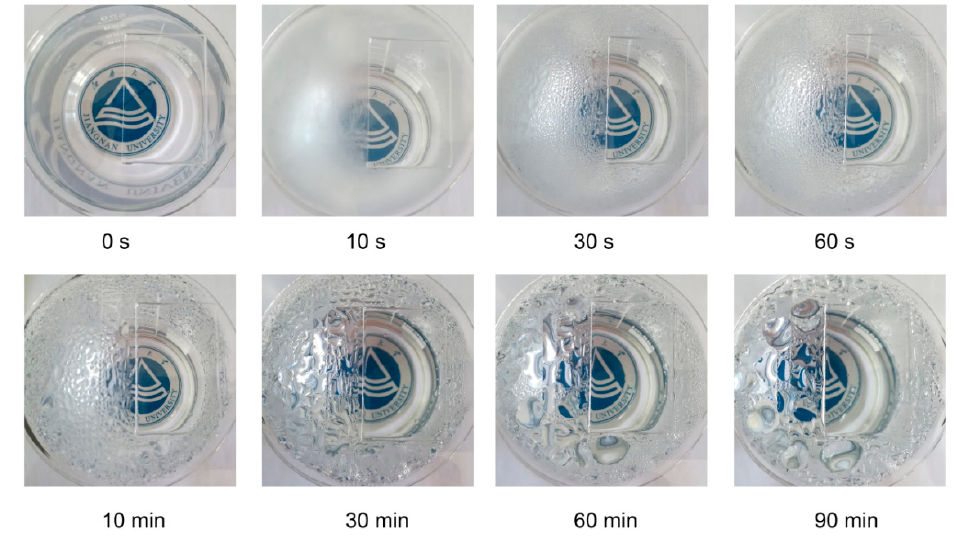
Figure 9. Illustration of the antifogging property of the PAS gels.